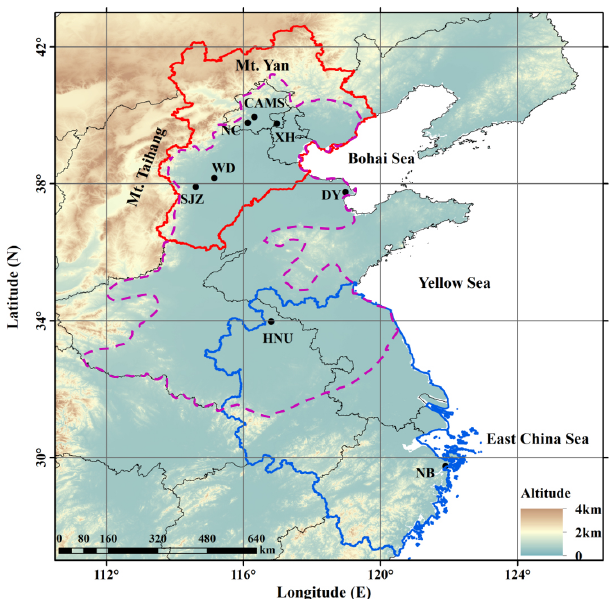
Figure 1. Study area location, topography, and distribution of MAX-DOAS stations: black points represent the stations; solid red contour line indicates the JJJ region; solid blue contour line shows the YRD region. Dashed purple contour line indicates the NCP re- gion. The map is depicted using ArcGIS 10.8 (ESRI